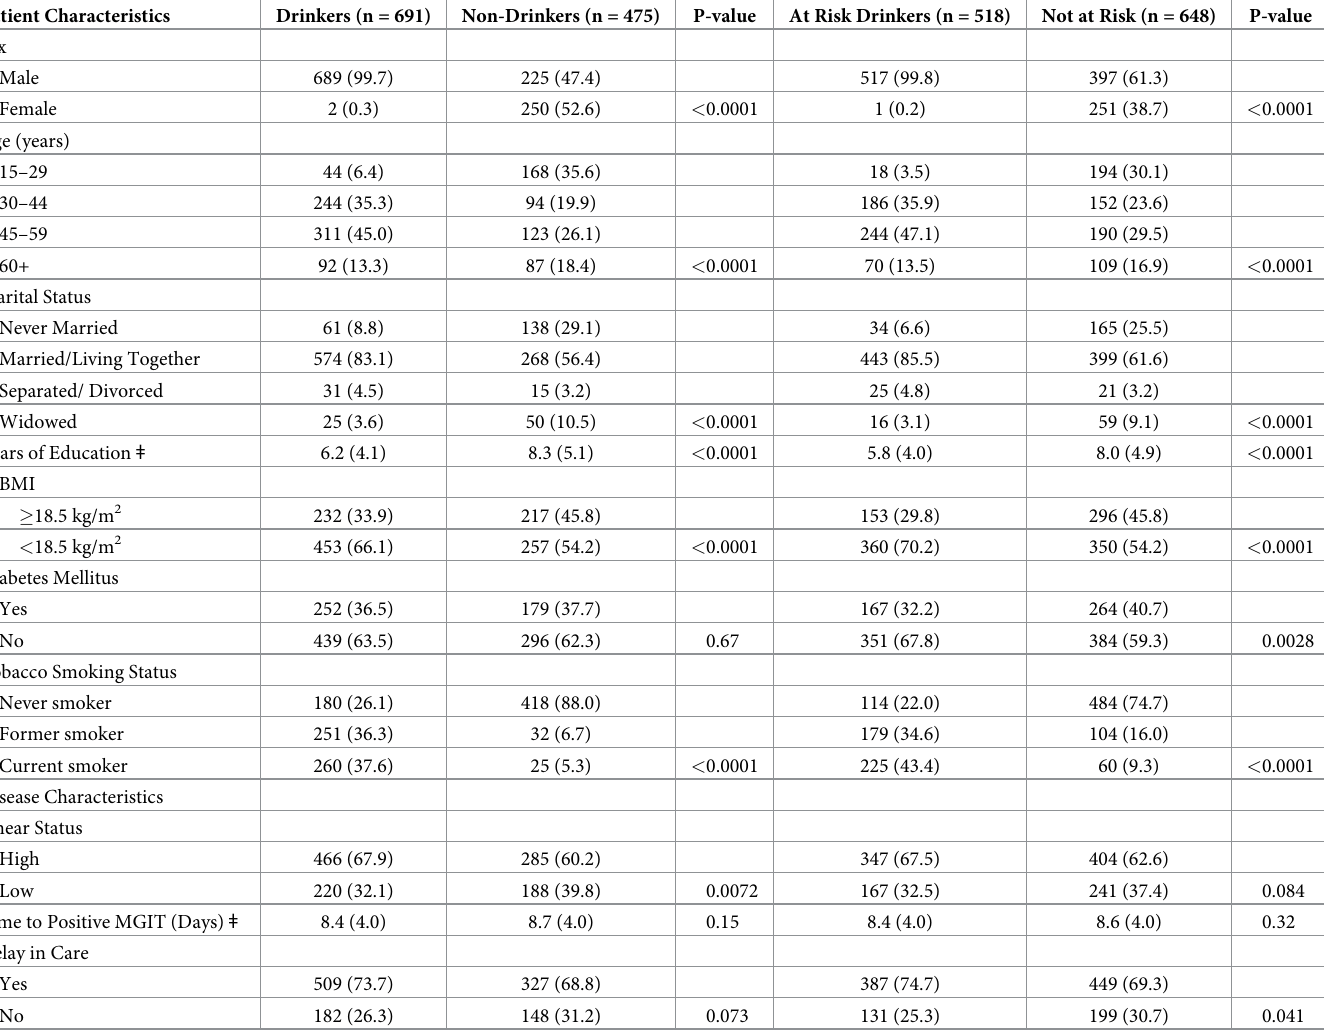
Table 1. Descriptive characteristics of new smear-positive pulmonary tuberculosis patients, stratified by any alcohol consumption and at-risk for alcohol use disor- der (N = 1166), n (%). Patient